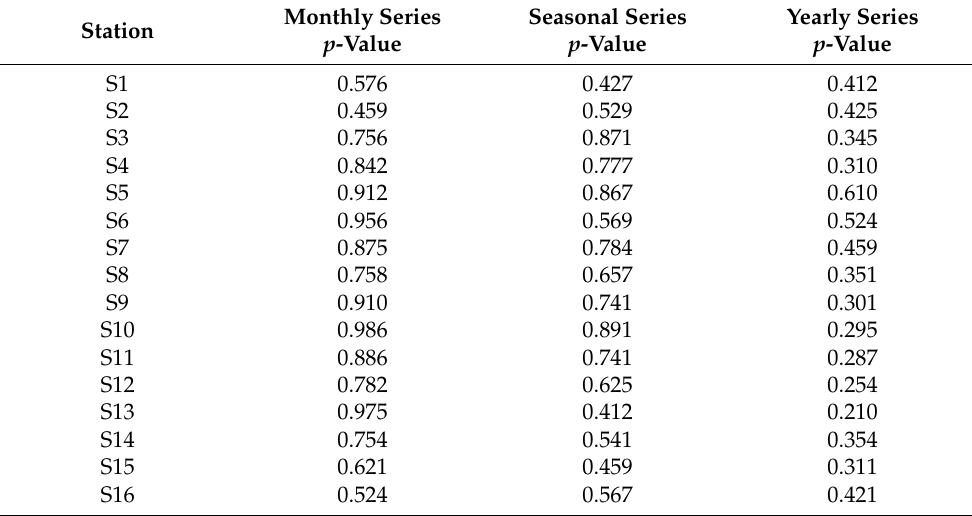
Table 3. Results of stationarity tests for the monthly, seasonal and yearly series. Station